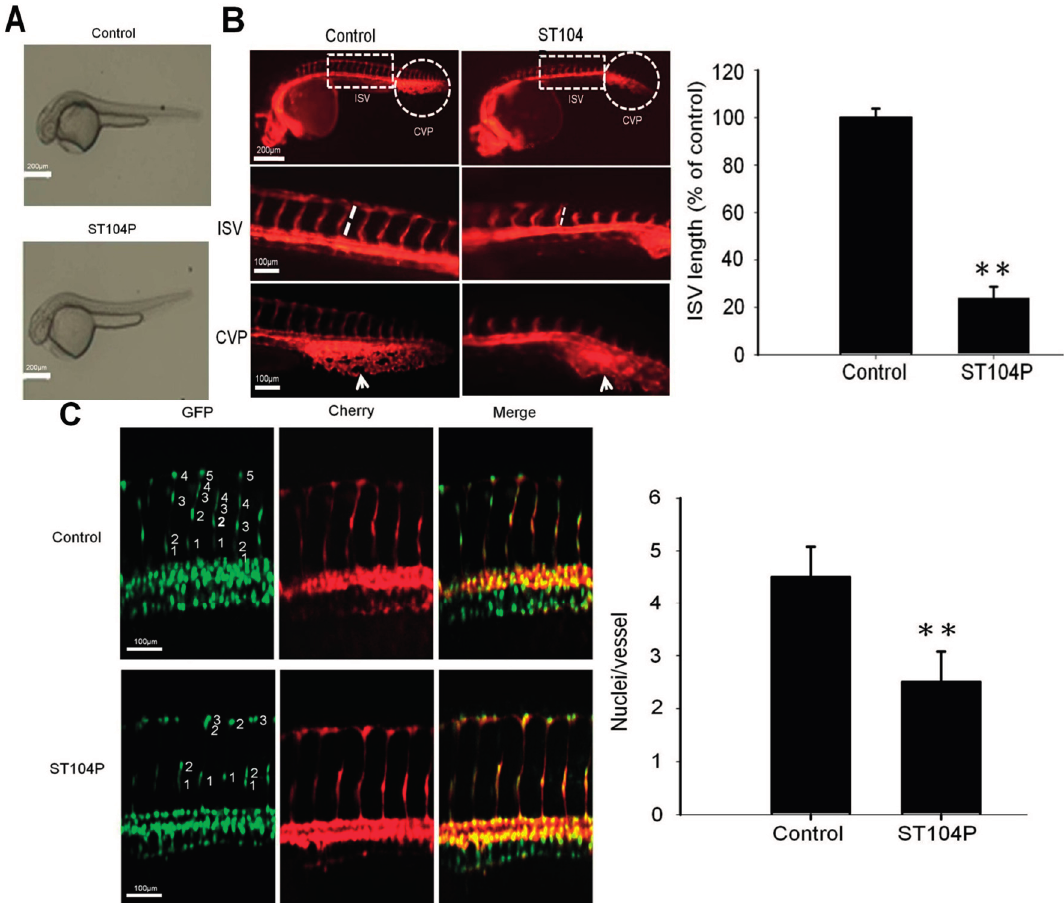
Figure 2. Effect of ST104P on vessel development in transgenic zebrafish models. The influence of ST104P (100 μ g/mL) application on blood vessel development in Tg(kdrl:mCherry) ci5 × Tg(fli1a:negfp) y7 zebrafish embryos were analyzed at various time intervals. ( A ) Bright-field images of ST104P-treated embryos (Scale bars = 200 µm); ( B ) Fluorescence microscopy analysis of ST104P-treated embryos at 30 h post fertilization (hpf). Upper panels show the anatomical locations of the intersegmental vessels (ISV) and caudal vein plexus (CVP) for observation (50× magnification; scale bars = 200 µm); Middle panel shows the measurements of ISV length (corresponding to the boxed area in the upper panel) in control and ST104P embryos. The sprouting length of ISV in embryos ( n = 10 per group) was analyzed at 30 hpf (100× magnification; scale bars = 100 µm). Data were mean ± SEM of triplicate experiments; Bottom panels highlight the morphology and neovascularization in CVP morphology as indicated by arrows; and ( C ) Quantification of endothelial number and migration in ISVs of ST104P-treated in transgenic Tg(kdrl:mCherry) ci5 × Tg(fli1a:negfp) y7 zebrafish. In this transgenic line, endothelial cells were labeled with green nuclei by negfp expression while the vessels were labeled with red by cytoplasmic mCherry expression. Images of ST104P-treated embryos were recorded at 48 hpf (200× magnification; scale bars = 100 µm). The number of endothelial cells on each vessel was quantified by counting the green nuclei on each red dorsal longitudinal anastomotic vessel (DLAV). Data were mean ± SEM of triplicate experiments. Asterisks indicate statistical significance versus control. ** p ˂